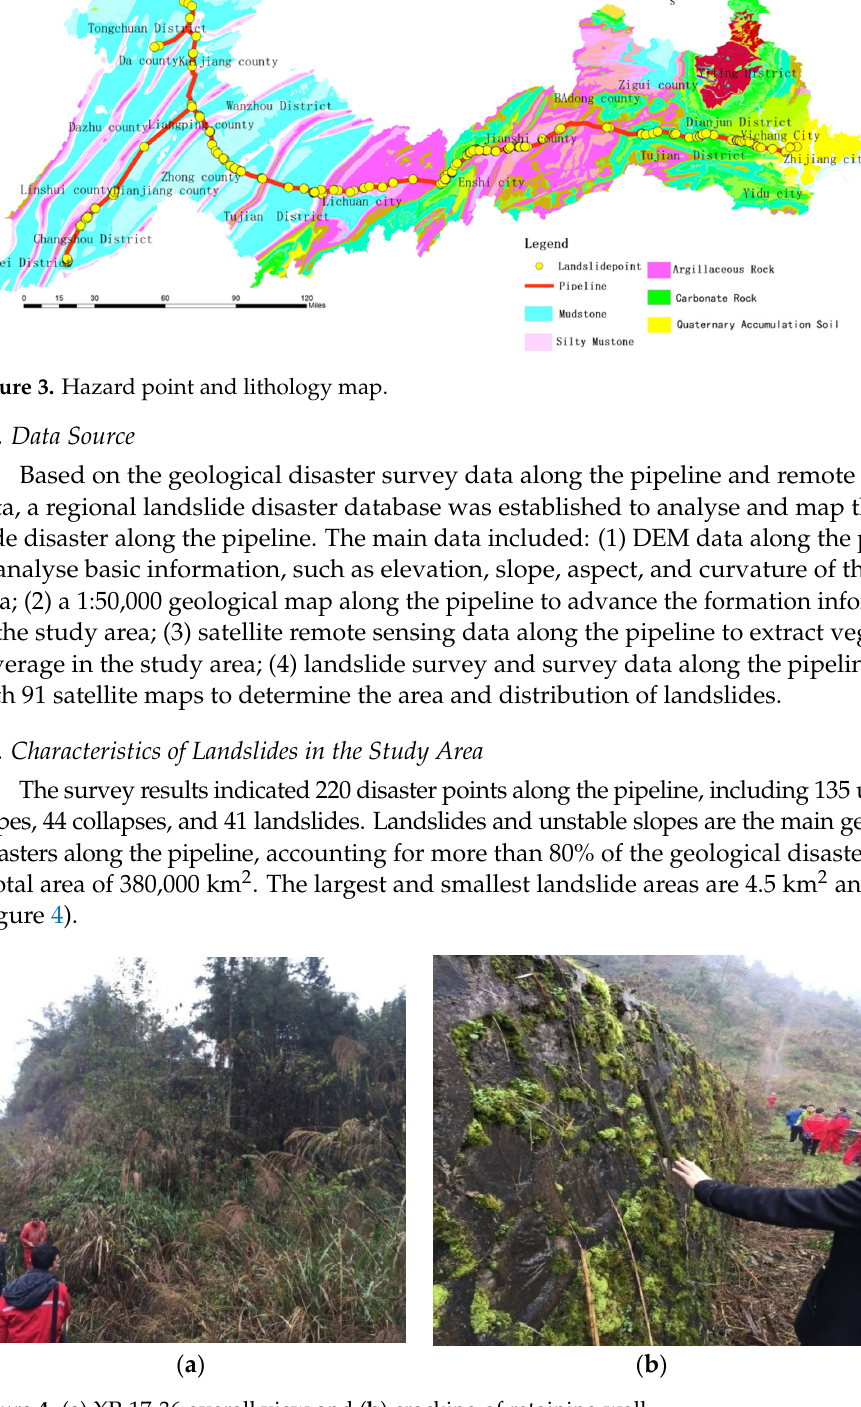
Figure 4. ( a ) XP-17-36 overall view and ( b ) cracking of retaining